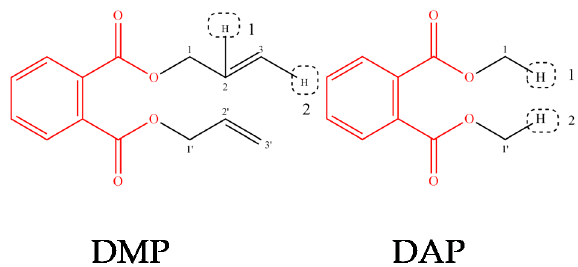
Figure 2. Modification sites of target molecules DMP and diallyl phthalate (DAP).